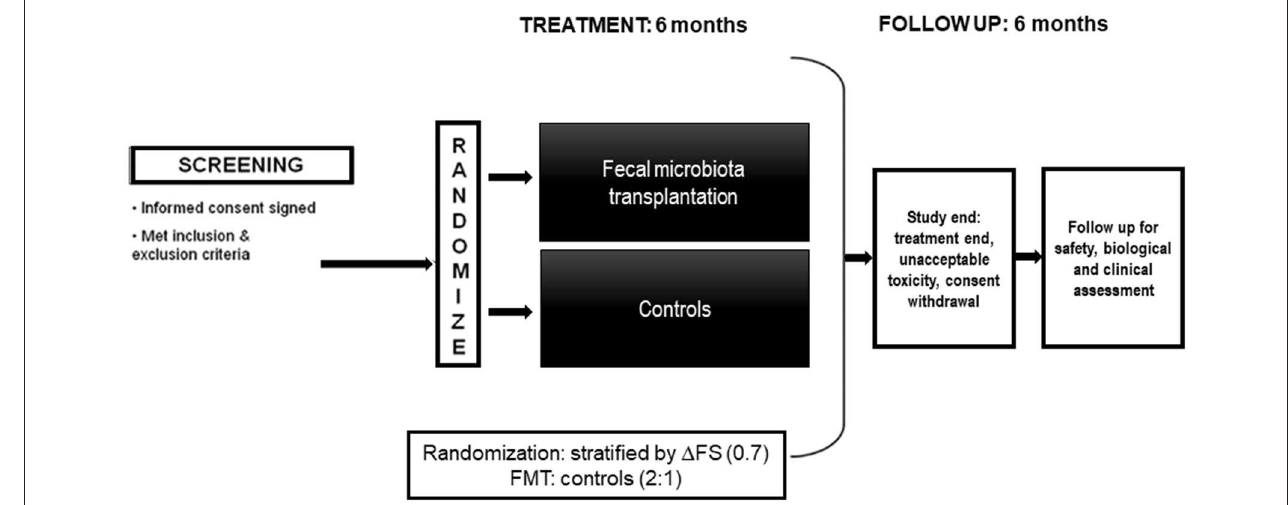
FIGURE 1 | Picture of the study